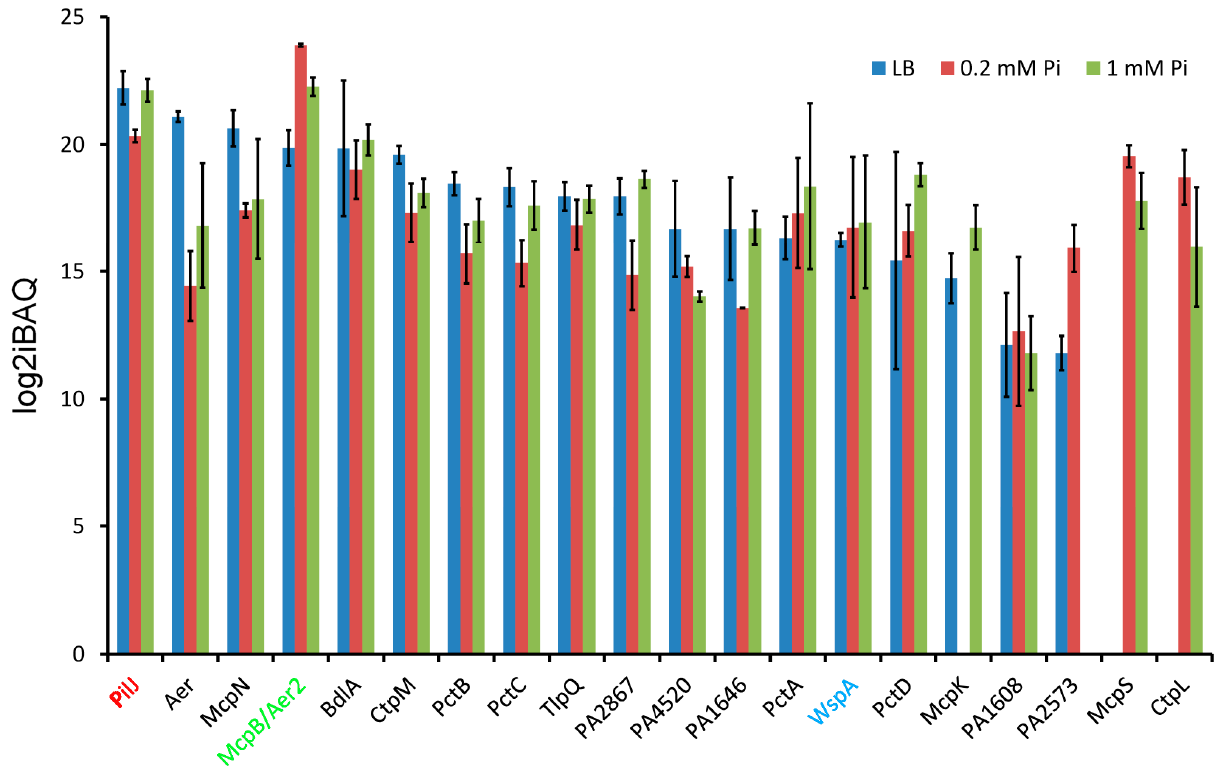
Figure 3. Chemoreceptor protein amounts in P. aeruginosa PAO1 grown in LB medium or minimal medium with 0.2 mM and 1 mM Pi. Chemoreceptors were ordered according to their protein amount in LB. Chemotaxis chemoreceptors are shown in black, whereas the chemoreceptors that stimulate the Chp, Che2, and Wsp pathways are shown in red, green, and blue, respectively. Error bars indicate standard deviations from the mean intensity Based Absolute Quantification (iBAQ) index.